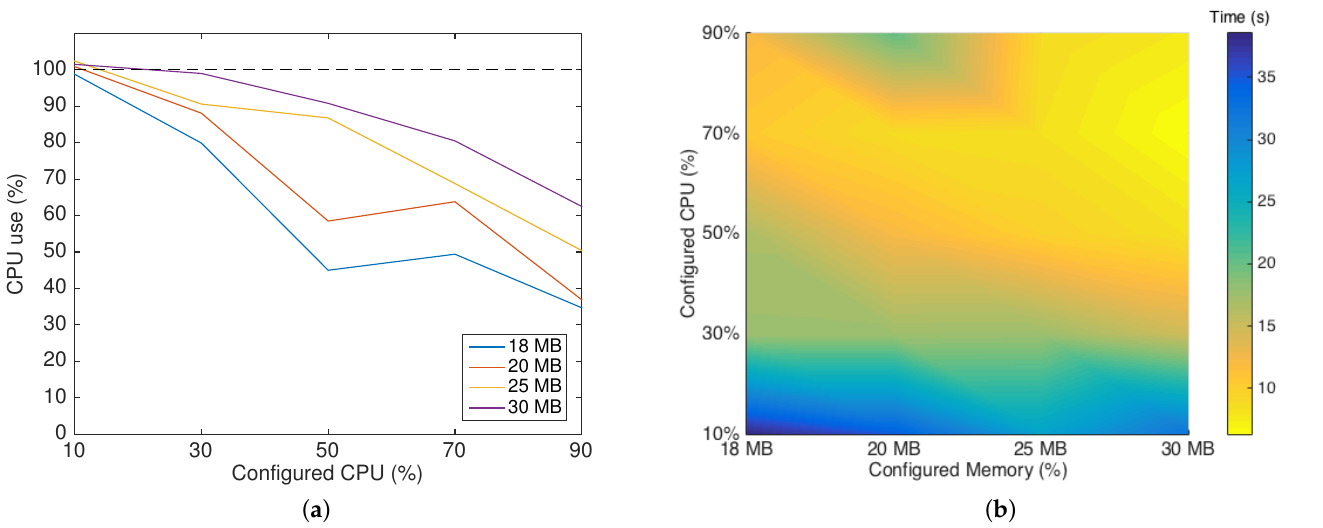
Figure 9. Dockerized client performance. ( a ) Percentage of used CPU in each setup. ( b ) Client performance